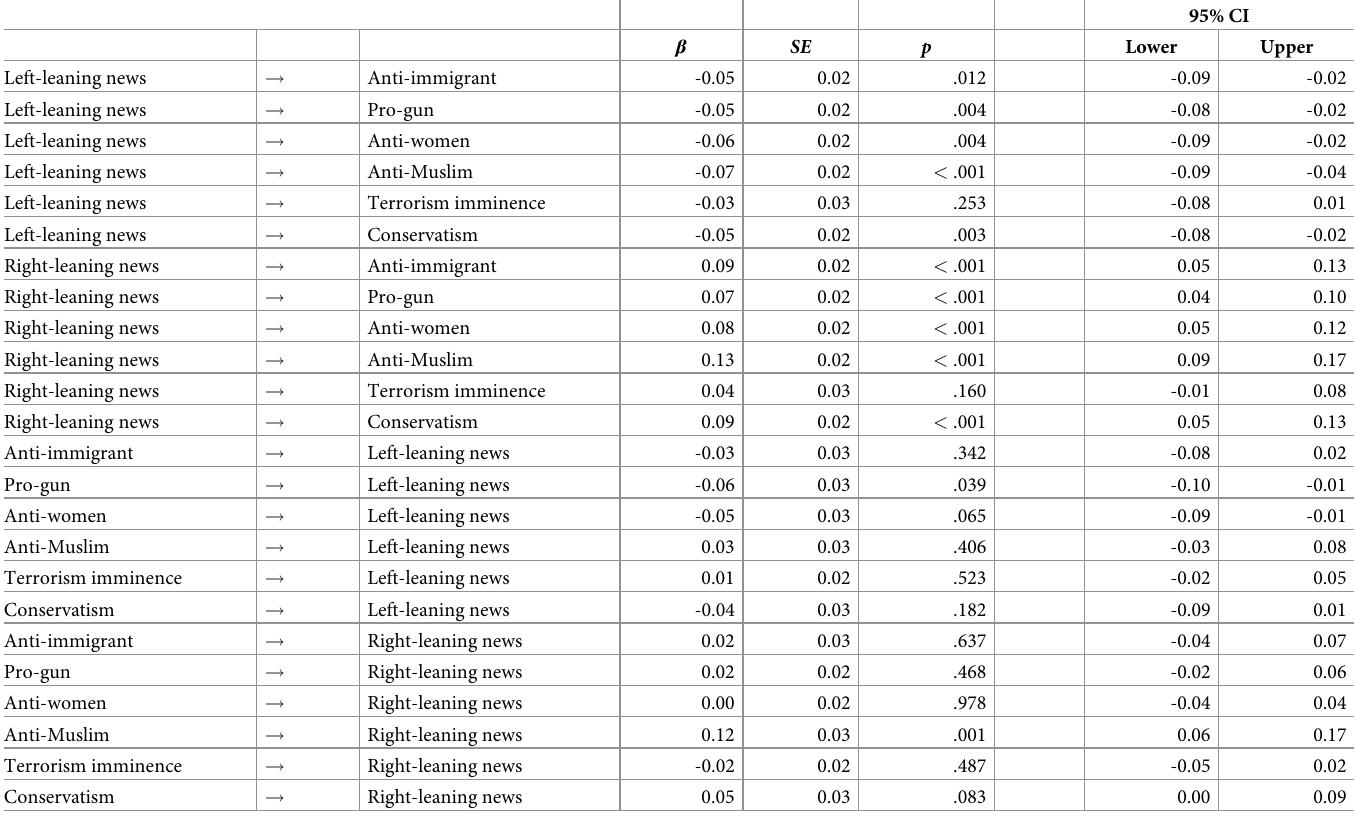
Table 3. W1-W2 and W2-W3 standardized cross-lagged paths in longitudinal